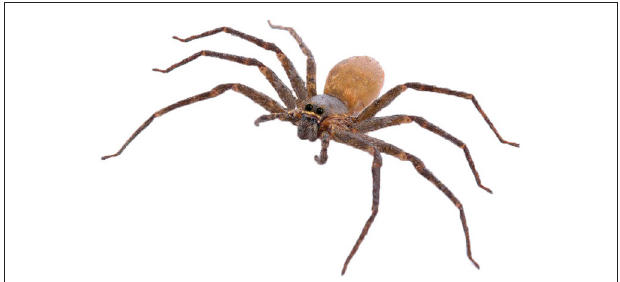
FIGURE 1 | Experimentally manipulated eyes of spider.